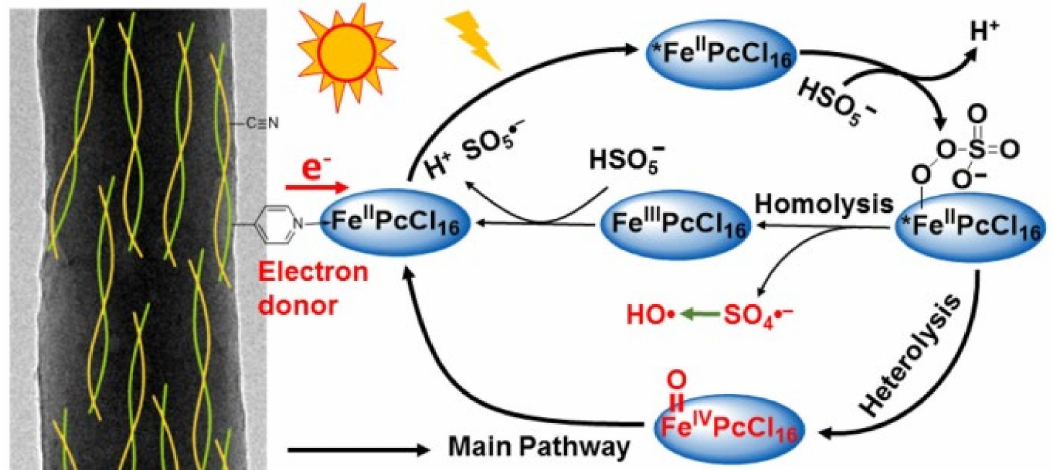
Figure 11. Proposed main pathway for the formation of active species when using FePcCl 16 -P 4 VP / PAN catalyst under visible-light irradiation ( λ > 420 nm) in CBZ photodegradation. Adapted with permission from ref. [69]. Copyright 2019 Springer